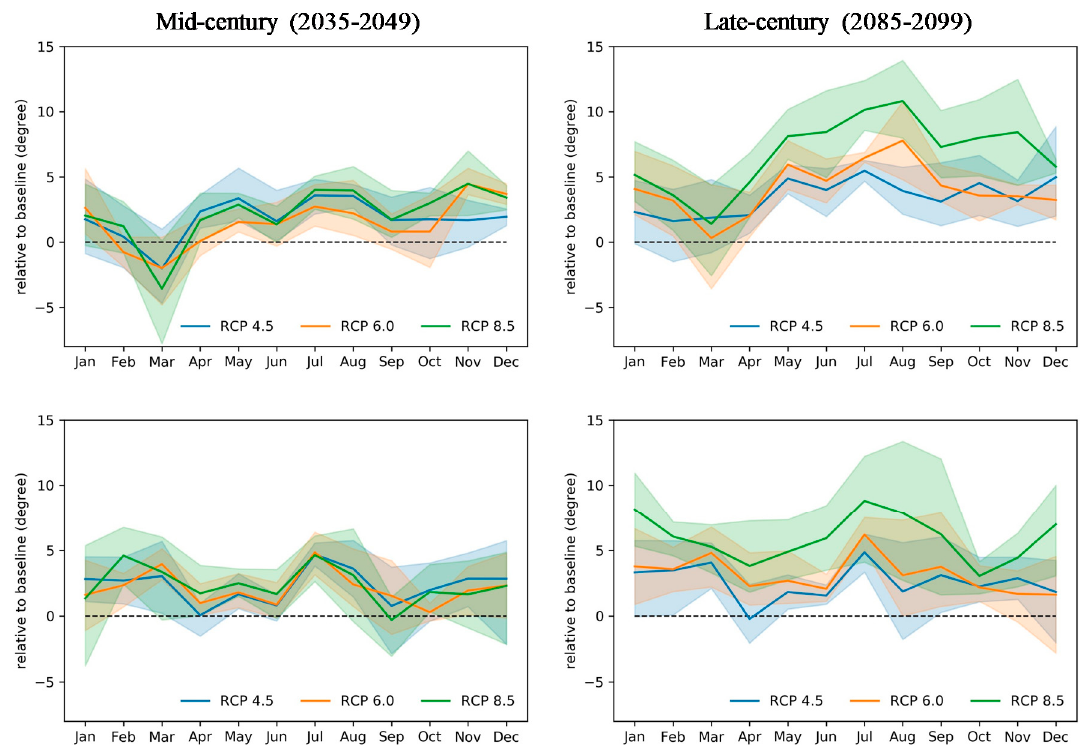
Figure 6. Seasonal variation of monthly maximum and minimum temperatures during mid (2035–2049) and late century (2085–2099) relative to baseline period (1986–2000) for three RCPs (4.5, 6, and 8.5). The straight lines show the mean monthly maximum and minimum temperatures, and the shaded area shows the range of the temperature variation within the GCMs.